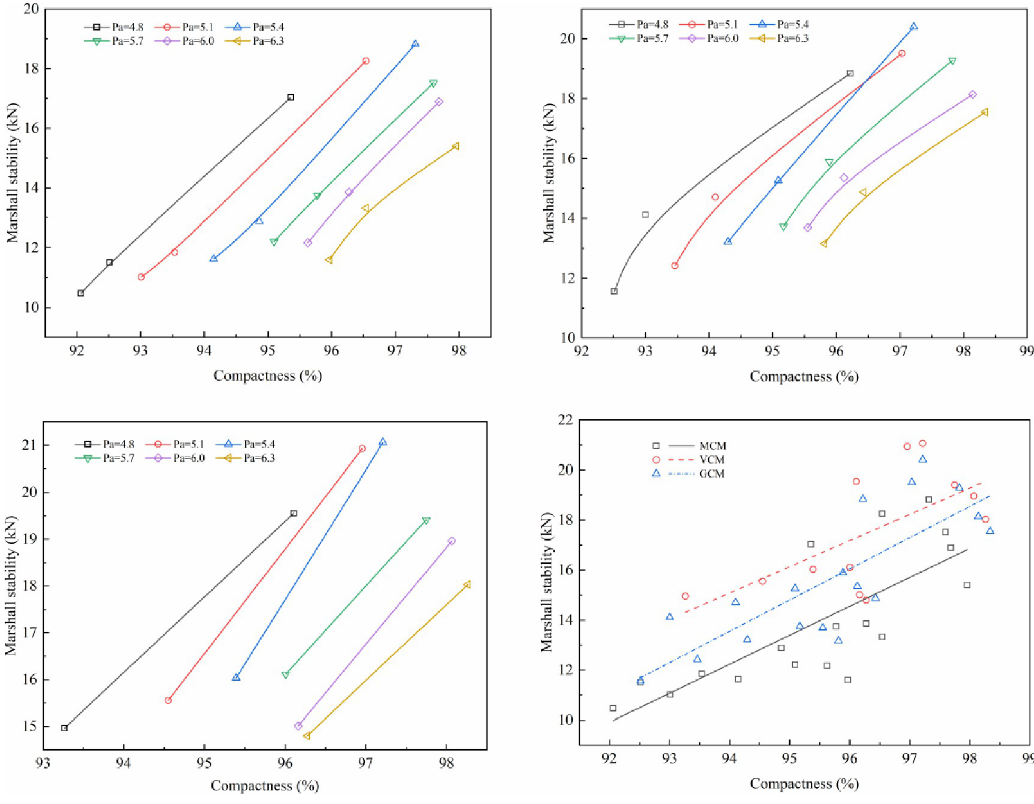
Fig 11. The relationship between Marshall stability and compactness. (a)Marshall stability versus compactness under MCM (b) Marshall stability versus compactness under GCM. (c)Marshall stability versus compactness under VCM (d) Relationship between Marshall stability and